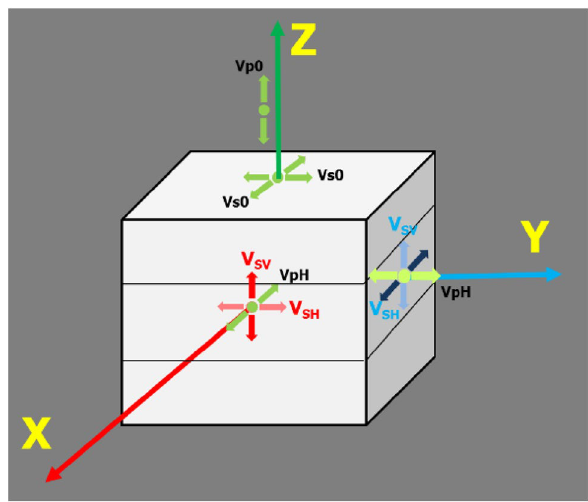
Fig. 2 Model to show polarization of velocities in a different direc- tion for TI media. SV is the shear wave in the vertical direction, SH is the shear wave in the horizontal direction, and PH is the compres- sional wave in the horizontal direction